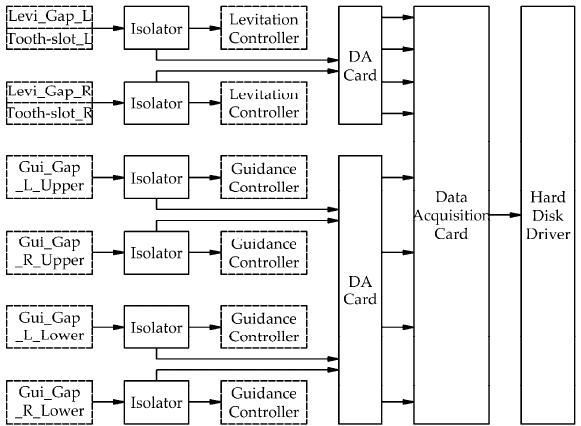
Figure 2. Data collection flowchart.